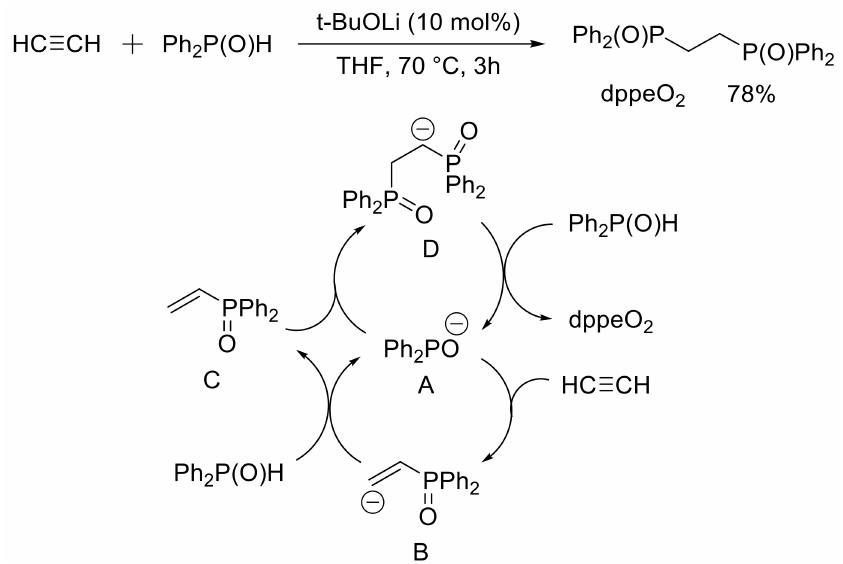
Scheme 85. A mechanism proposed for the formation of dppe